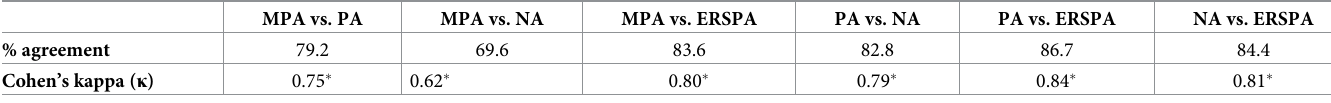
Table 3. Interrater agreement on dipole source localization between each method. MPA vs. PA